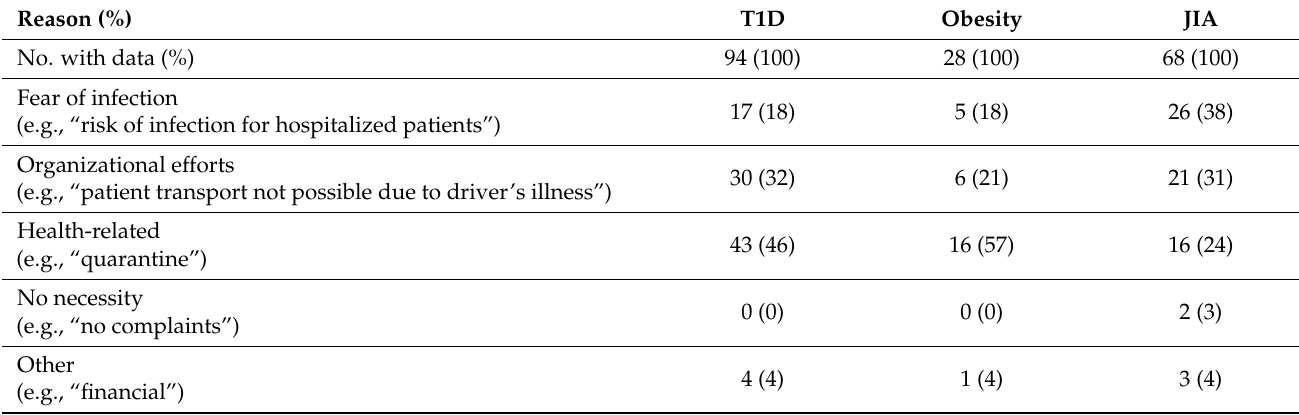
Table 2. Reported reasons for cancellation of